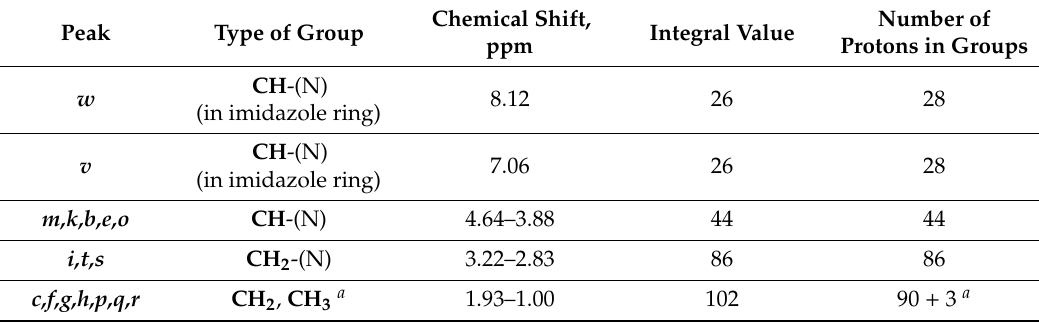
Figure 2. 1 H NMR spectrum of Lis-2His dendrimer in D 2 O at 25 ◦ C. Table 1. Chemical shift assignments and integral Table 1. Chemical shift assignments and integral values.